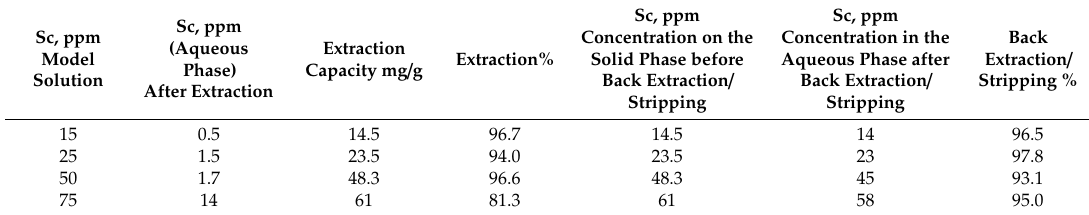
Table 1. Determination of scandium with UV spectroscopy after extraction and